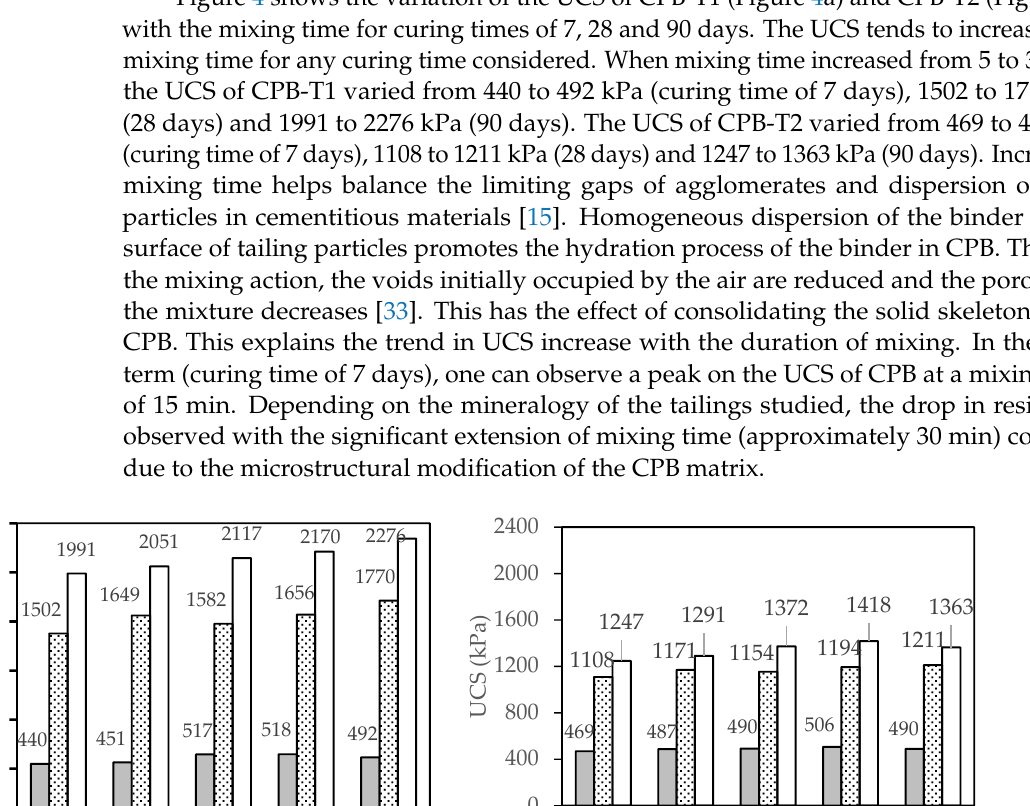
Figure 4. Effect of the mixing time on the UCS for mixtures at curing times of 7, 28 and 90 days for: ( a ) CPB-T1 and ( b ) CPB-T2.